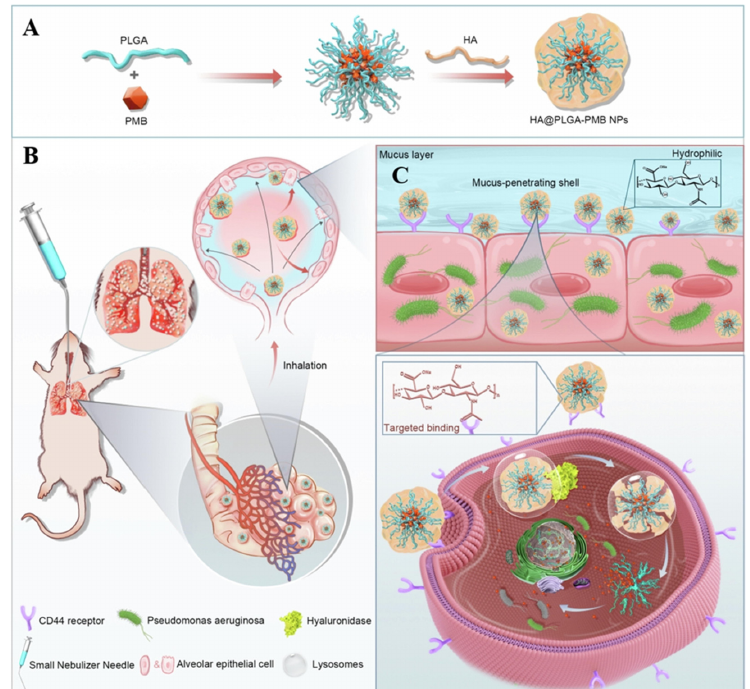
Figure 13. Schematic diagram of the preparation and nebulization of HA@PLGA-PMB nanoparticles for the treatment of lung infections. ( A ) Synthesis route of HA@PLGA-PMB nanoparticles. ( B ) Sche- matic diagram of nebulized administration of HA@PLGA-PMB nanoparticles in a mouse lung in- fection model. ( C ) Mucus penetration and cellular uptake processes of HA@PLGA-PMB nanoparti- cles. Modified and reproduced with permission from the Elsevier [145].